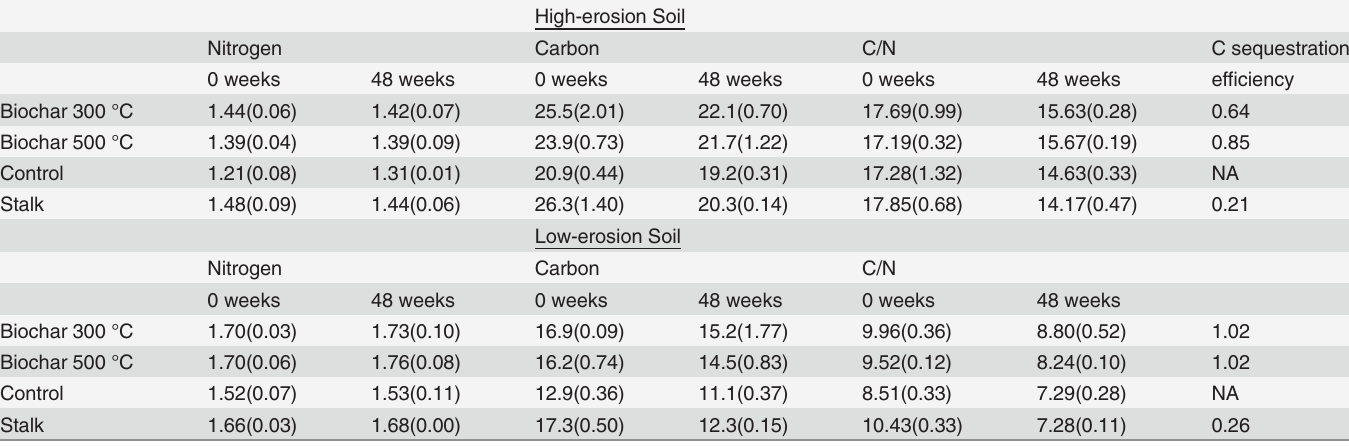
Table 5. Total soil C, N, C/N and C sequestration efficiency of the control soils and soil amended with corn stalks, 300 °C char, and 500 °C char be- fore the incubation and at the end of the